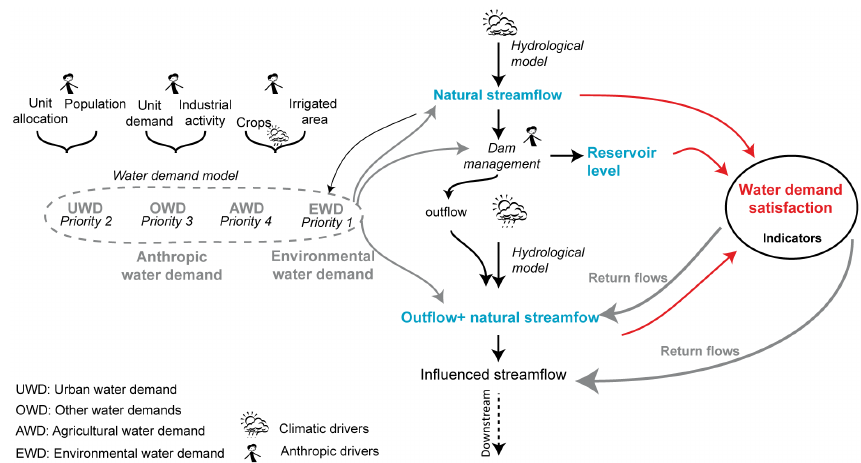
Figure 1. Integrative modelling framework applied on the Herault and Ebro